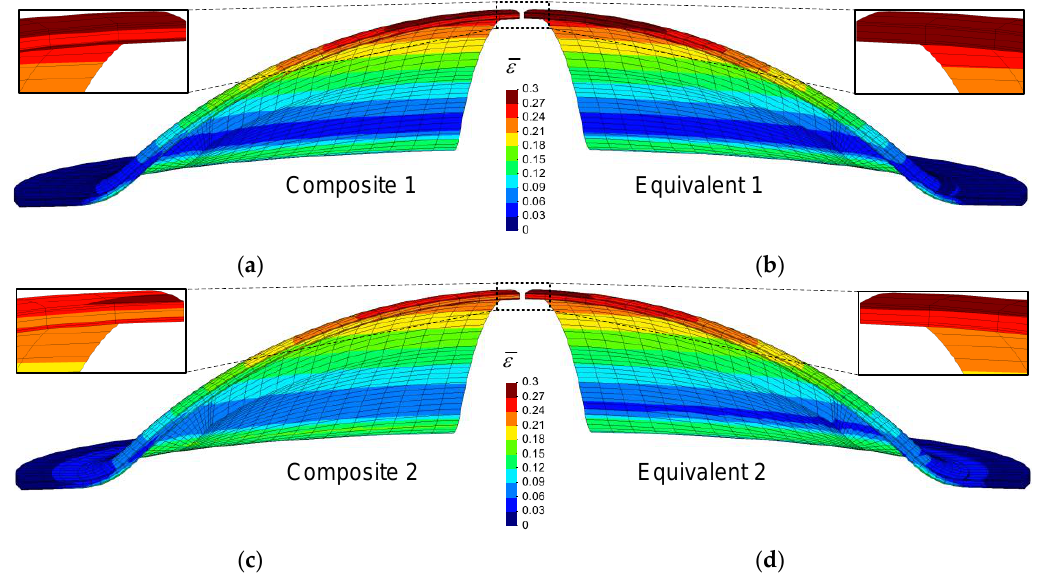
Figure 7. Distribution of the equivalent plastic strain at the end of the bulge test for the: ( a ) Composite 1; ( b ) equivalent material 1; ( c ) Composite 2; ( d ) equivalent material 2.